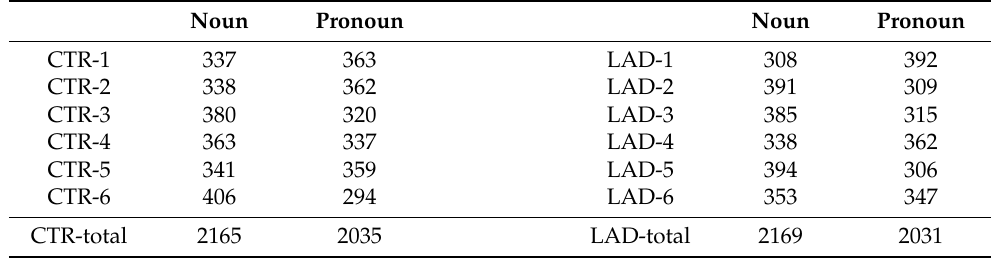
Table 3. Proportion of nouns and pronouns (database: first 750 nouns and pronouns produced by each subject).